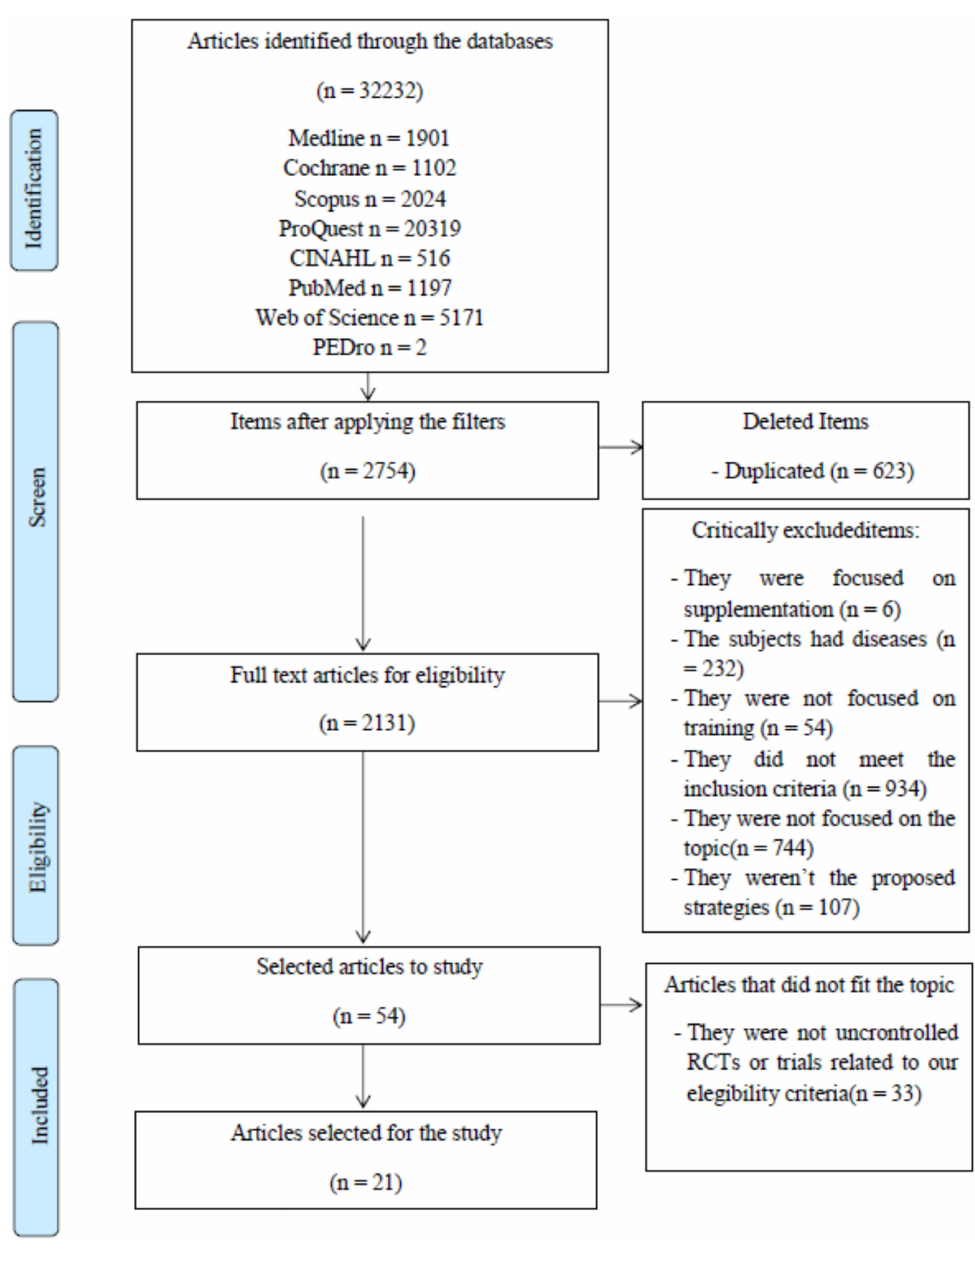
Figure 1. PRISMA screening process for selection of articles for